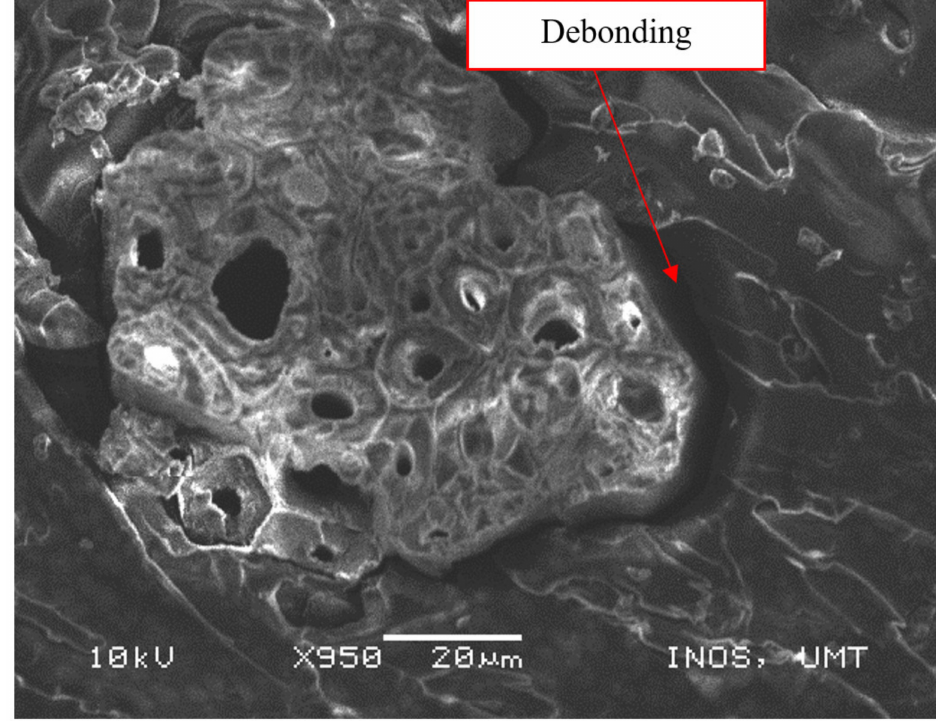
Figure 11. Debonding of fiber and polymer in the epoxy/PET/KF-35